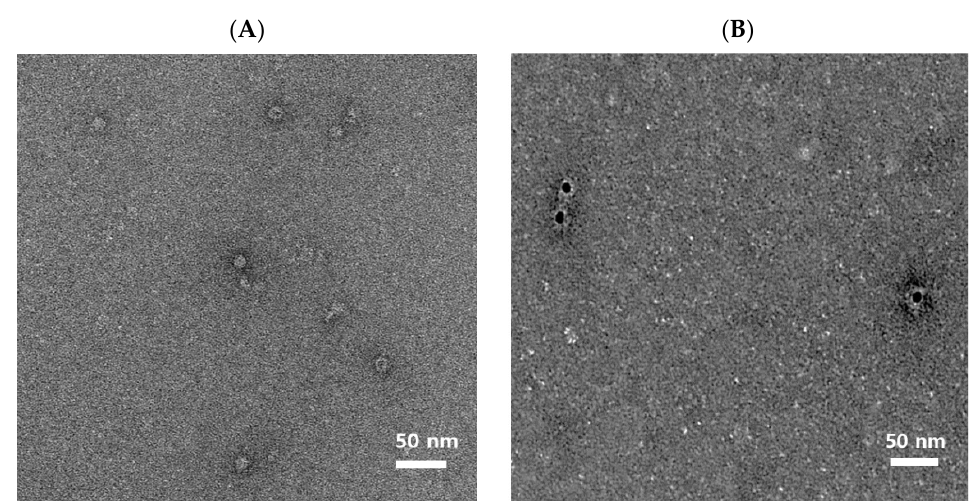
Figure 1. Molecular weight of the purified HEV-3-239-VLPs. The recombinant rabbit HEV whole capsid protein expressed by the E. coli system has a molecular weight of 72 kDa (lane 1). The mon- omer of HEV-3-239-VLP expressed in the baculovirus system has a molecular weight of 26 kDa (lane 2).